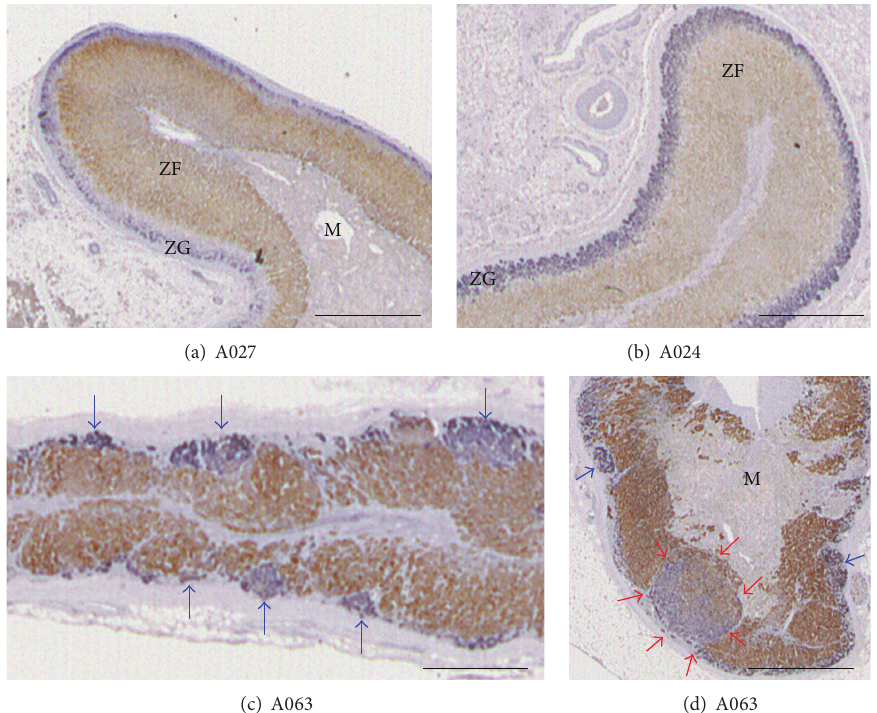
Figure 1: Double immunohistochemistry for CYP11B2 (blue) and CYP11B1 (brown). (a) Section A027 from Case 7; (b) section A024 from Case 4; (c) section A063 from Case 40; (d) section A063 from Case 40. These are enlarged images of frames in Supplementary Figure 1. Bars indicate 1mm. Blue and red arrows indicate APCCs and pAATL,